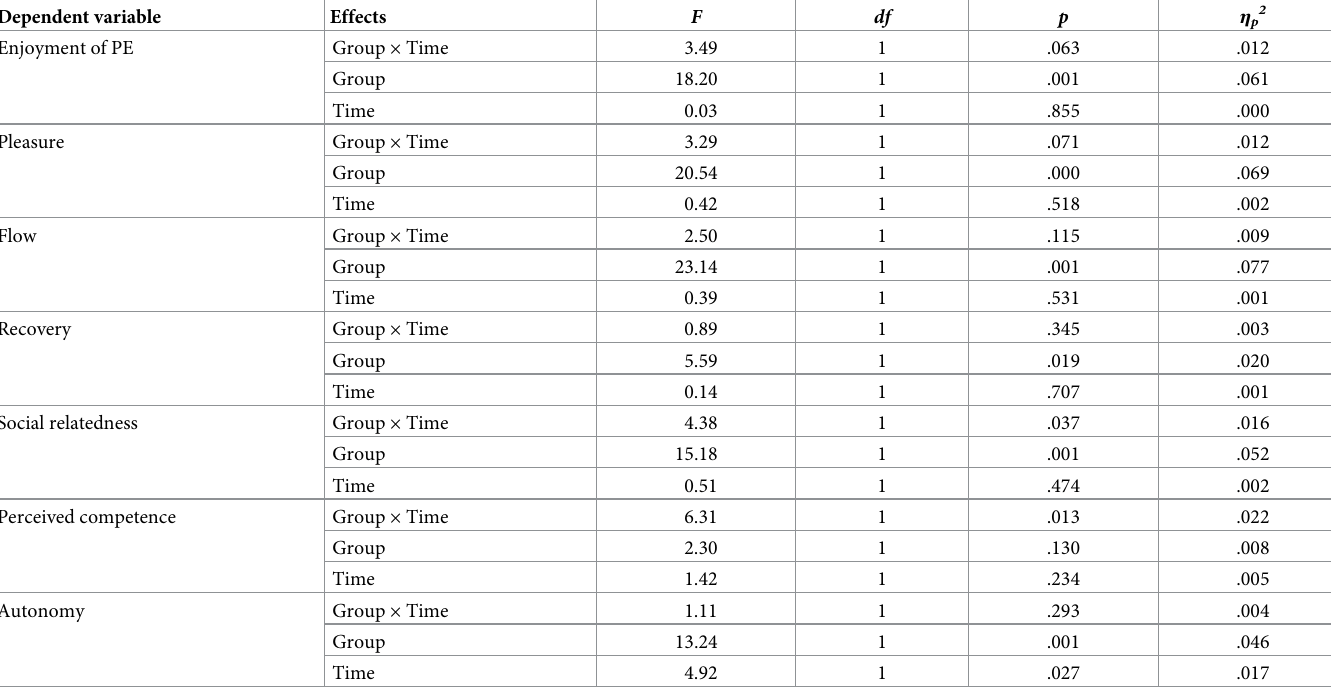
Table 3. Effects of interaction testing Hypothesis 1, Hypothesis 2, Hypothesis 4, and exploratory for autonomy as well as main and time